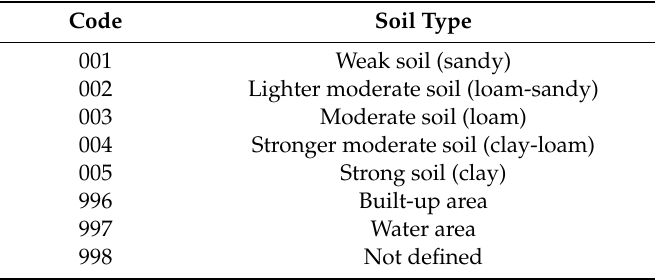
Table 3. Codes of soil types according to [38].